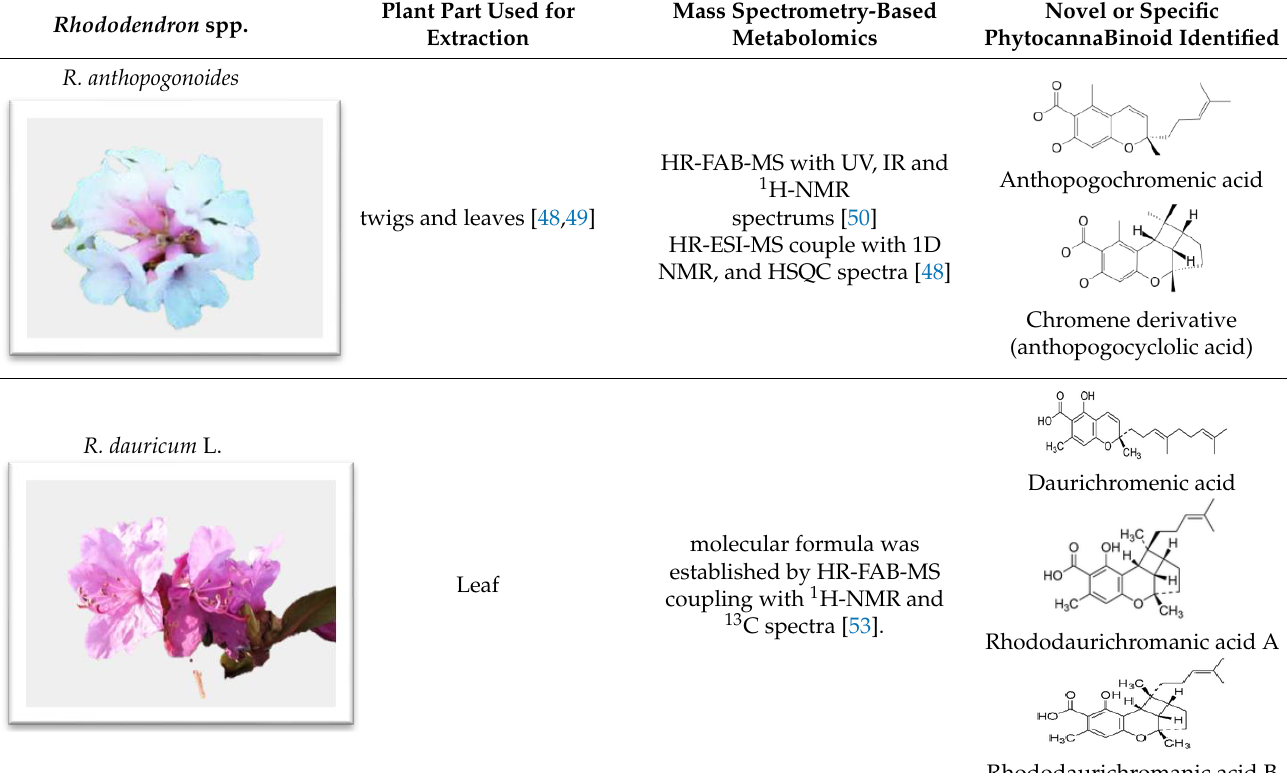
Table 2. Phytocannabinoid characterisation from different Rhododendron spp.